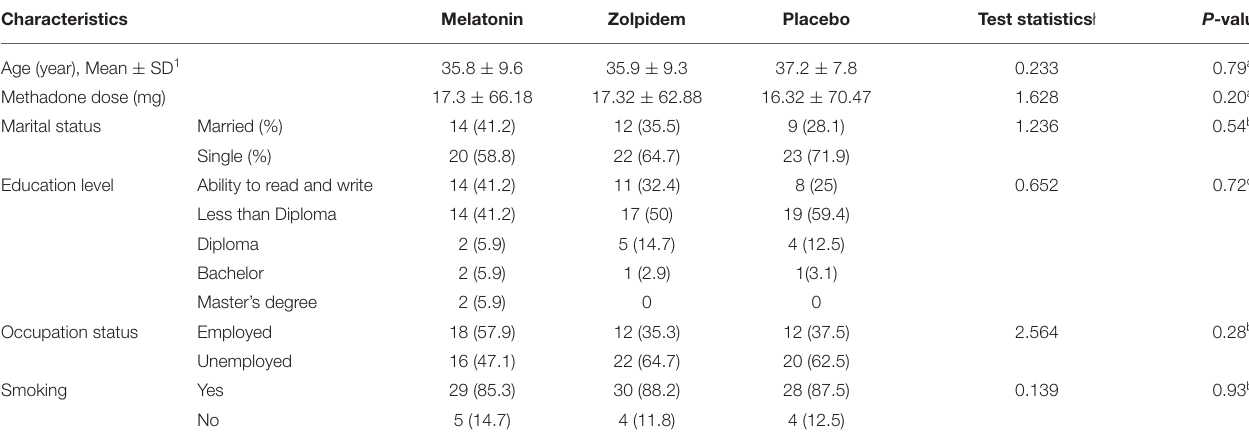
TABLE 1 | Comparison of demographic characteristics in the study population. Characteristics